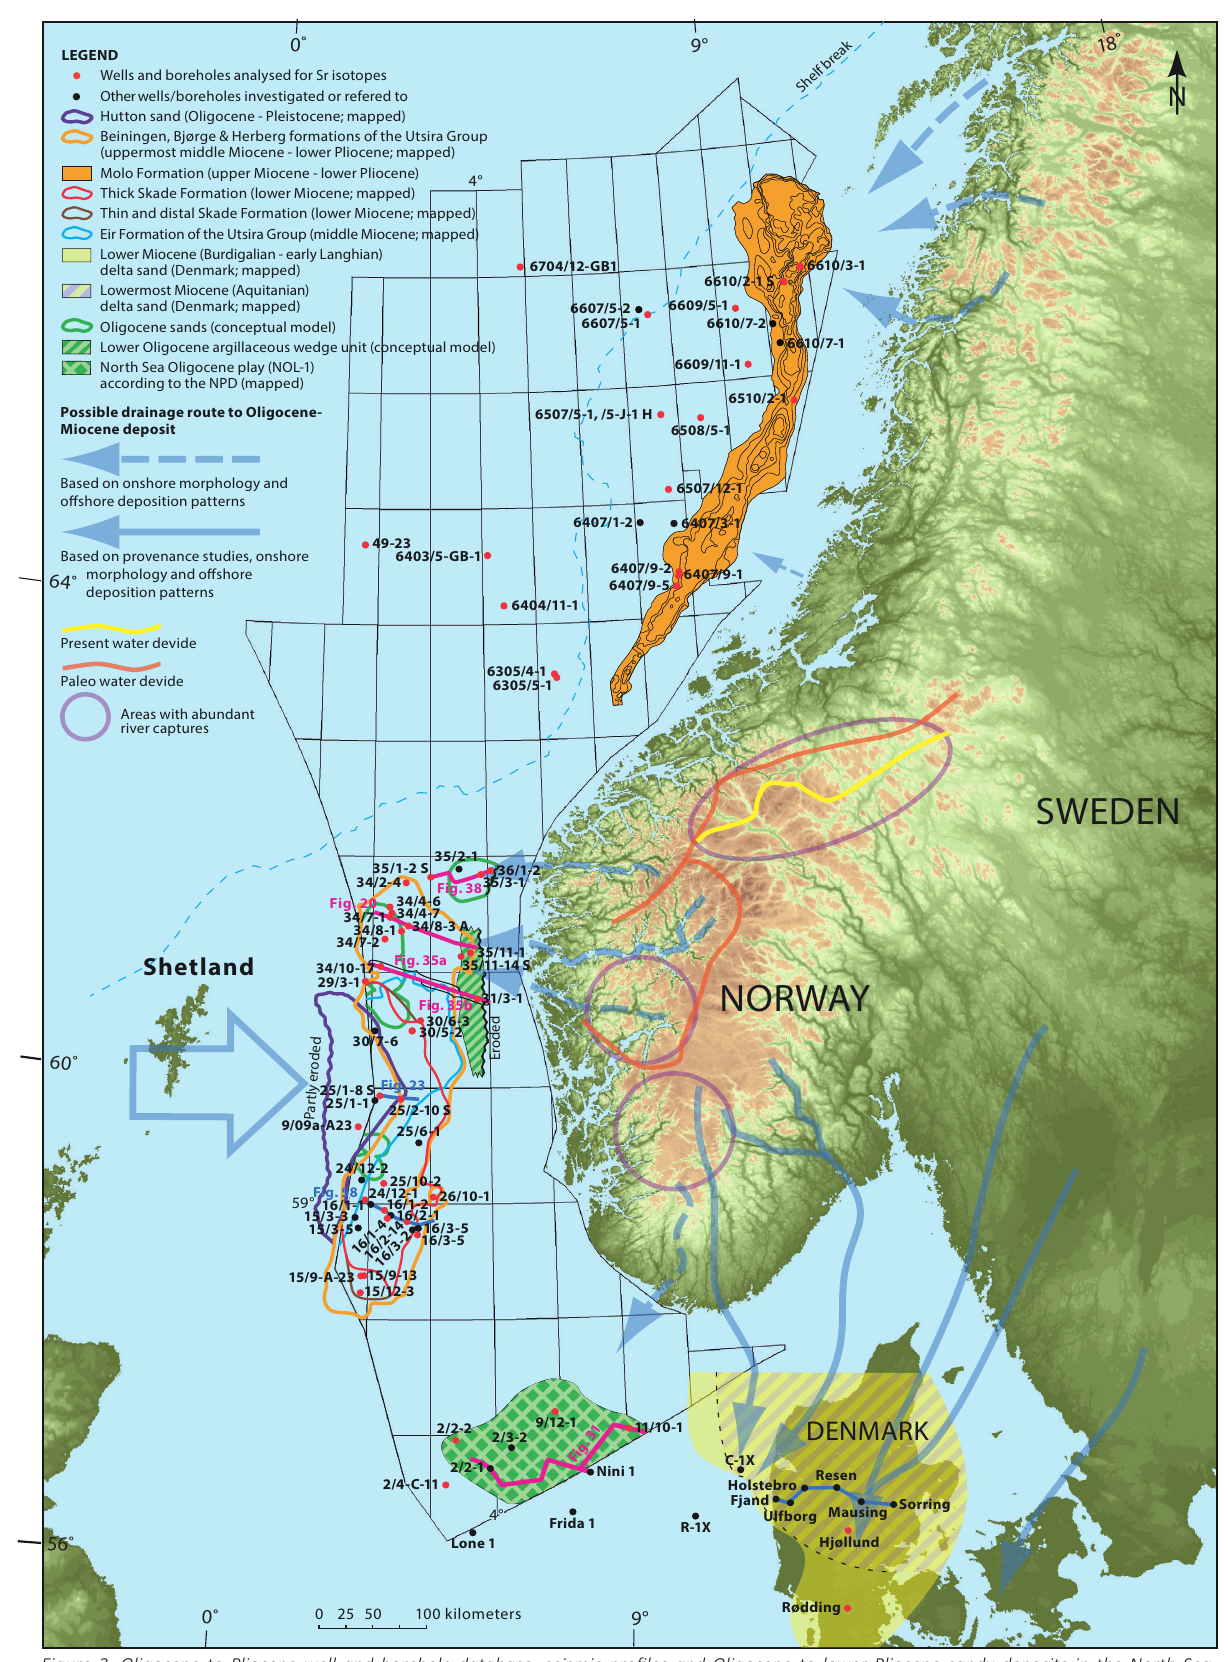
Figure 2. Oligocene to Pliocene well and borehole database, seismic profiles and Oligocene to lower Pliocene sandy deposits in the North Sea, Norwegian Sea and on the Norwegian Sea continental shelf. The extent of the Oligocene sands and wedge units are according to Rundberg & Eidvin (2005). The extent of the Beiningen, Bjørge, Herberg, Eir and Skade formations in the North Sea is according to NPD (npd.no/facts). The extent of the Molo Formation is after Bullimore et al. (2005) and the extent of the Hutton sand (informal) is after Gregersen & Johannessen (2007). The extent of the North Sea Oligocene play (NOL–1) is according to the NPD (npd.no/facts). The provenance study is after Olivarius et al. (2014) and the topographic map is after Olesen et al.